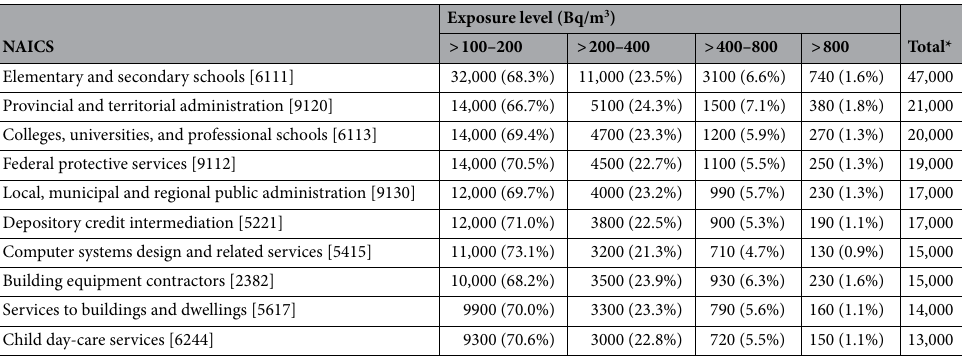
Table 3. Estimated number of workers exposed to radon by level of exposure and top 10 4-digit Industries (NAICS 2012). *Number of exposed may not add up to total because of rounding; row percentage in bracket.